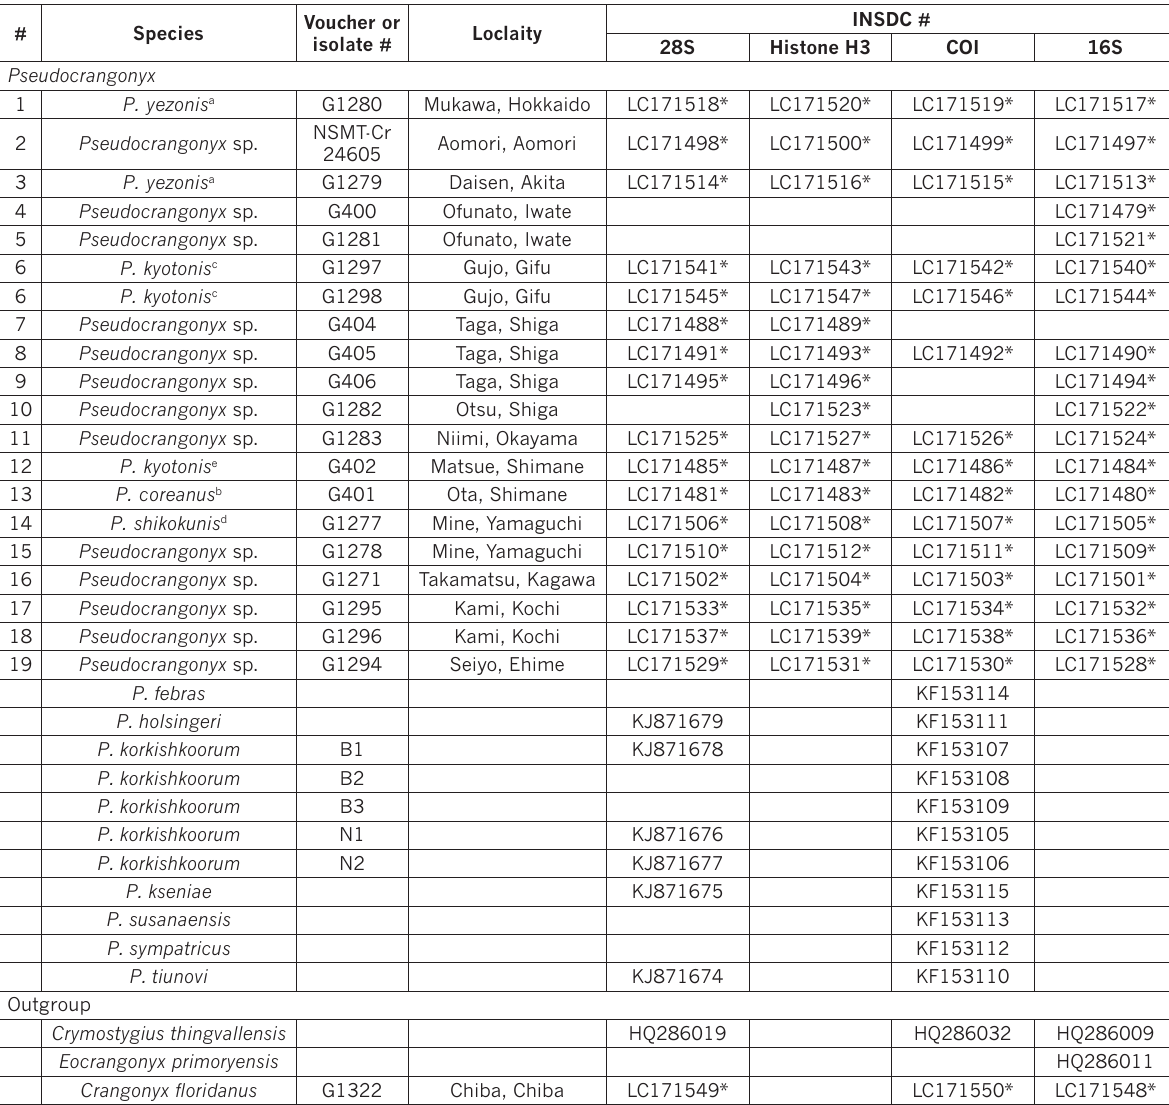
Table 1. Samples used for the phylogenetic analyses. The information on the vouchers is accompanied by the collection localities and the INSDC accession numbers. Sequences marked with an asterisk were obtained for the first time in the present study. Acro - nym: NSMT, the Tsukuba Collection Center of the National Museum of Nature and Science, Tokyo. Identification sources: a,